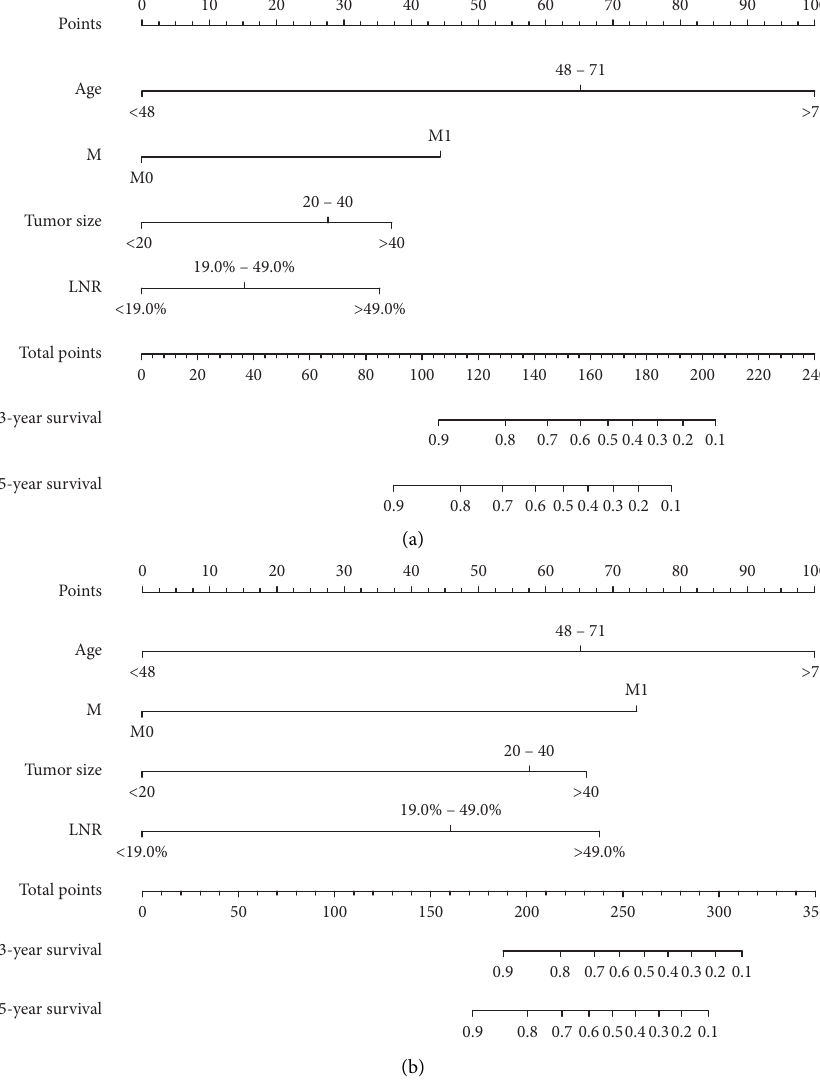
Figure 2: Nomograms to predict 3- and 5-year overall survival (a) and cancer-specific survival (b) for MTC patients who underwent total thyroidectomy and neck lymph nodes